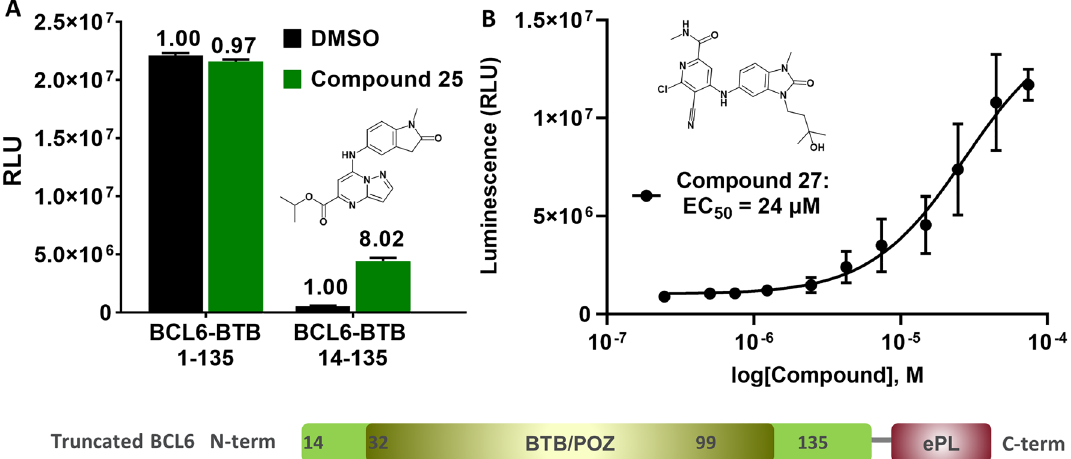
Figure 6. InCELL Hunter™ cellular target engagement assay. ( A ) HEK293T cells, transfected with DNA plasmids expressing complete C -terminally ePL-tagged BCL6 BTB (amino-acids 1–135) or truncated BCL6 BTB (amino-acids 14–135), were incubated with the oxindole compound 25 (30 µM) for 6 h before luminescence was detected on a plate reader (error bars represents standard deviation from n = 3); ( B ) HEK293T cells, transfected with C -terminally ePL-tagged truncated BCL6 BTB 14–135, were incubated with increasing concentrations of the benzimidazolone compound 27 for 6 h before luminescence detection (EC 50 24 ± 9 µM, error bars represents standard deviation from n =